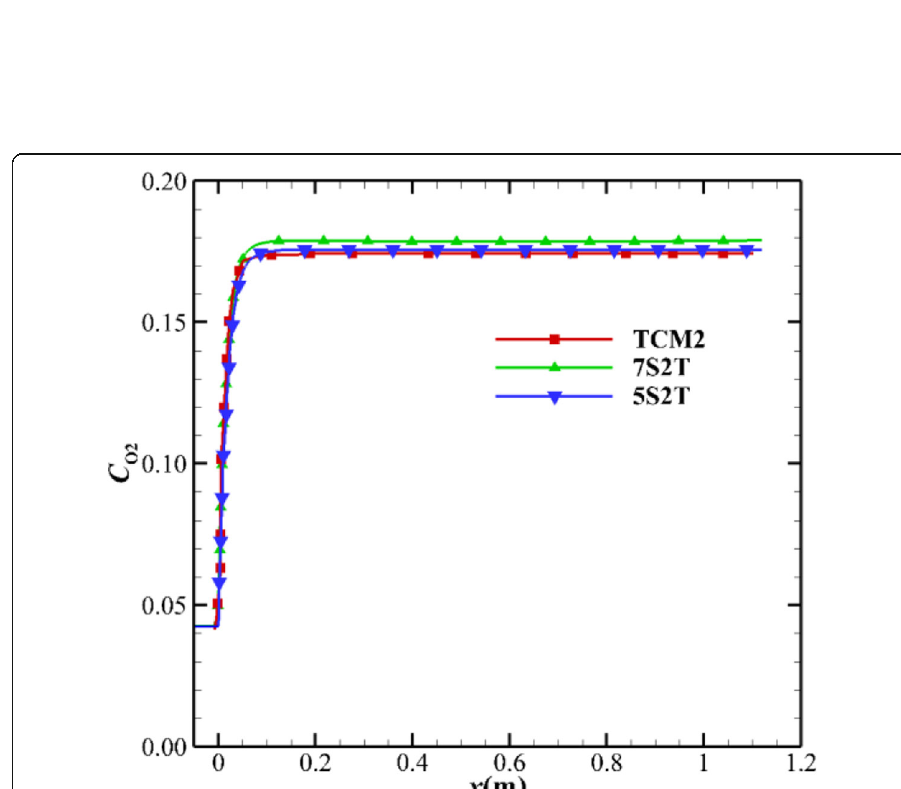
Fig. 3 Comparison of the centerline O 2 mass fraction